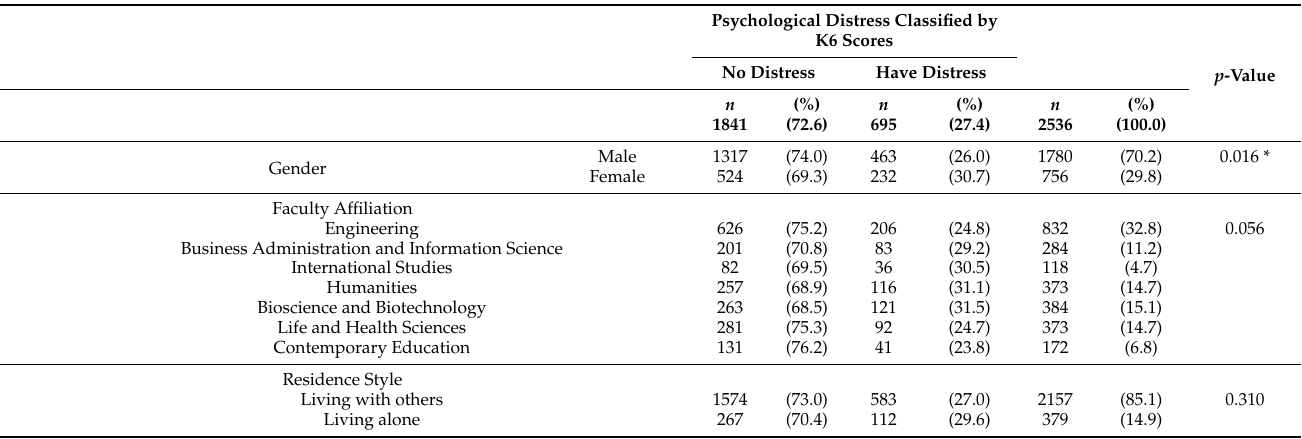
Table 2. Relationship between psychological distress and basic attributes, lifestyle, exercise habits, and physical health